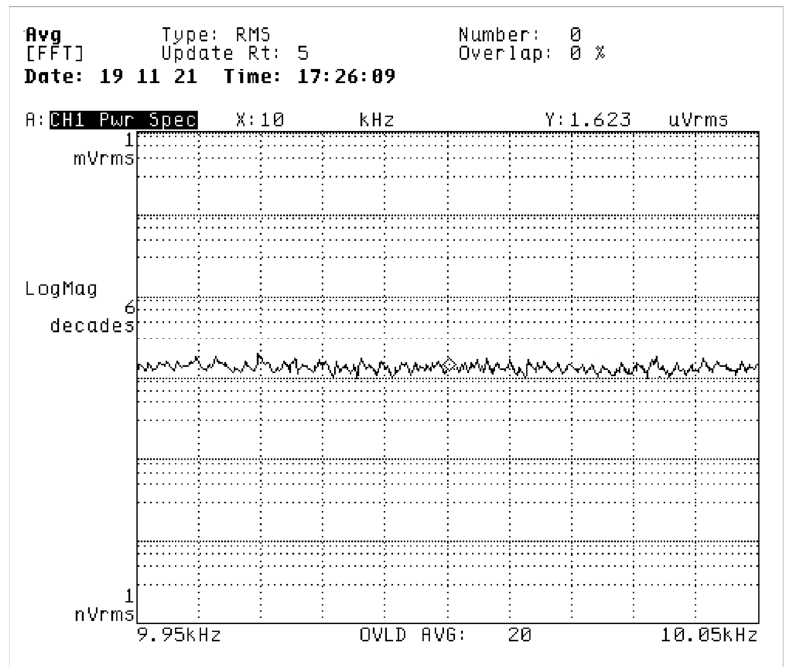
Figure 12. Output noise of pre-stage charge amplifier.